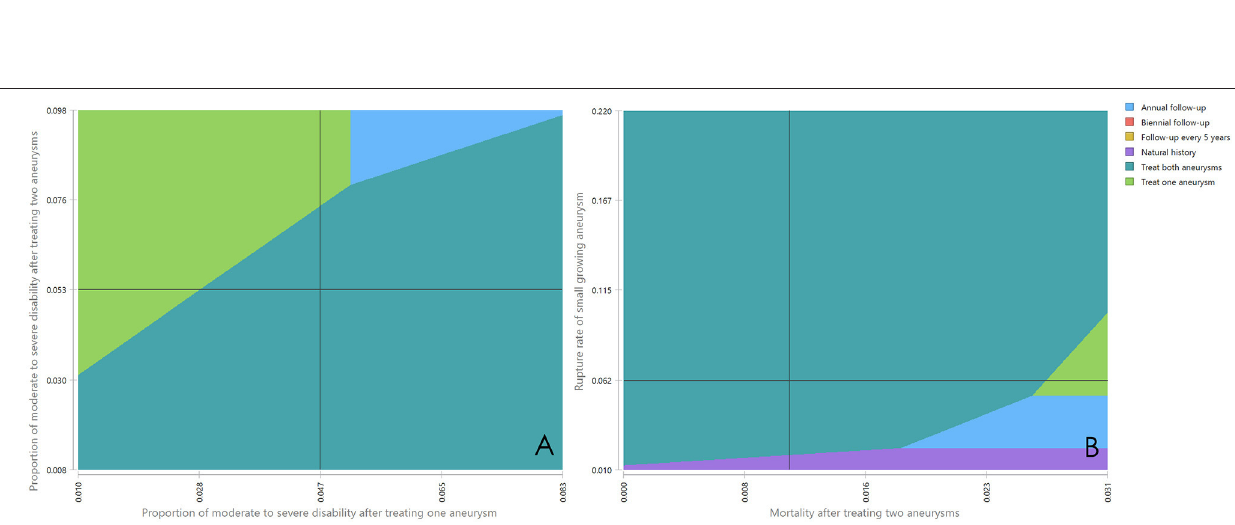
Frontiers in Neurology |